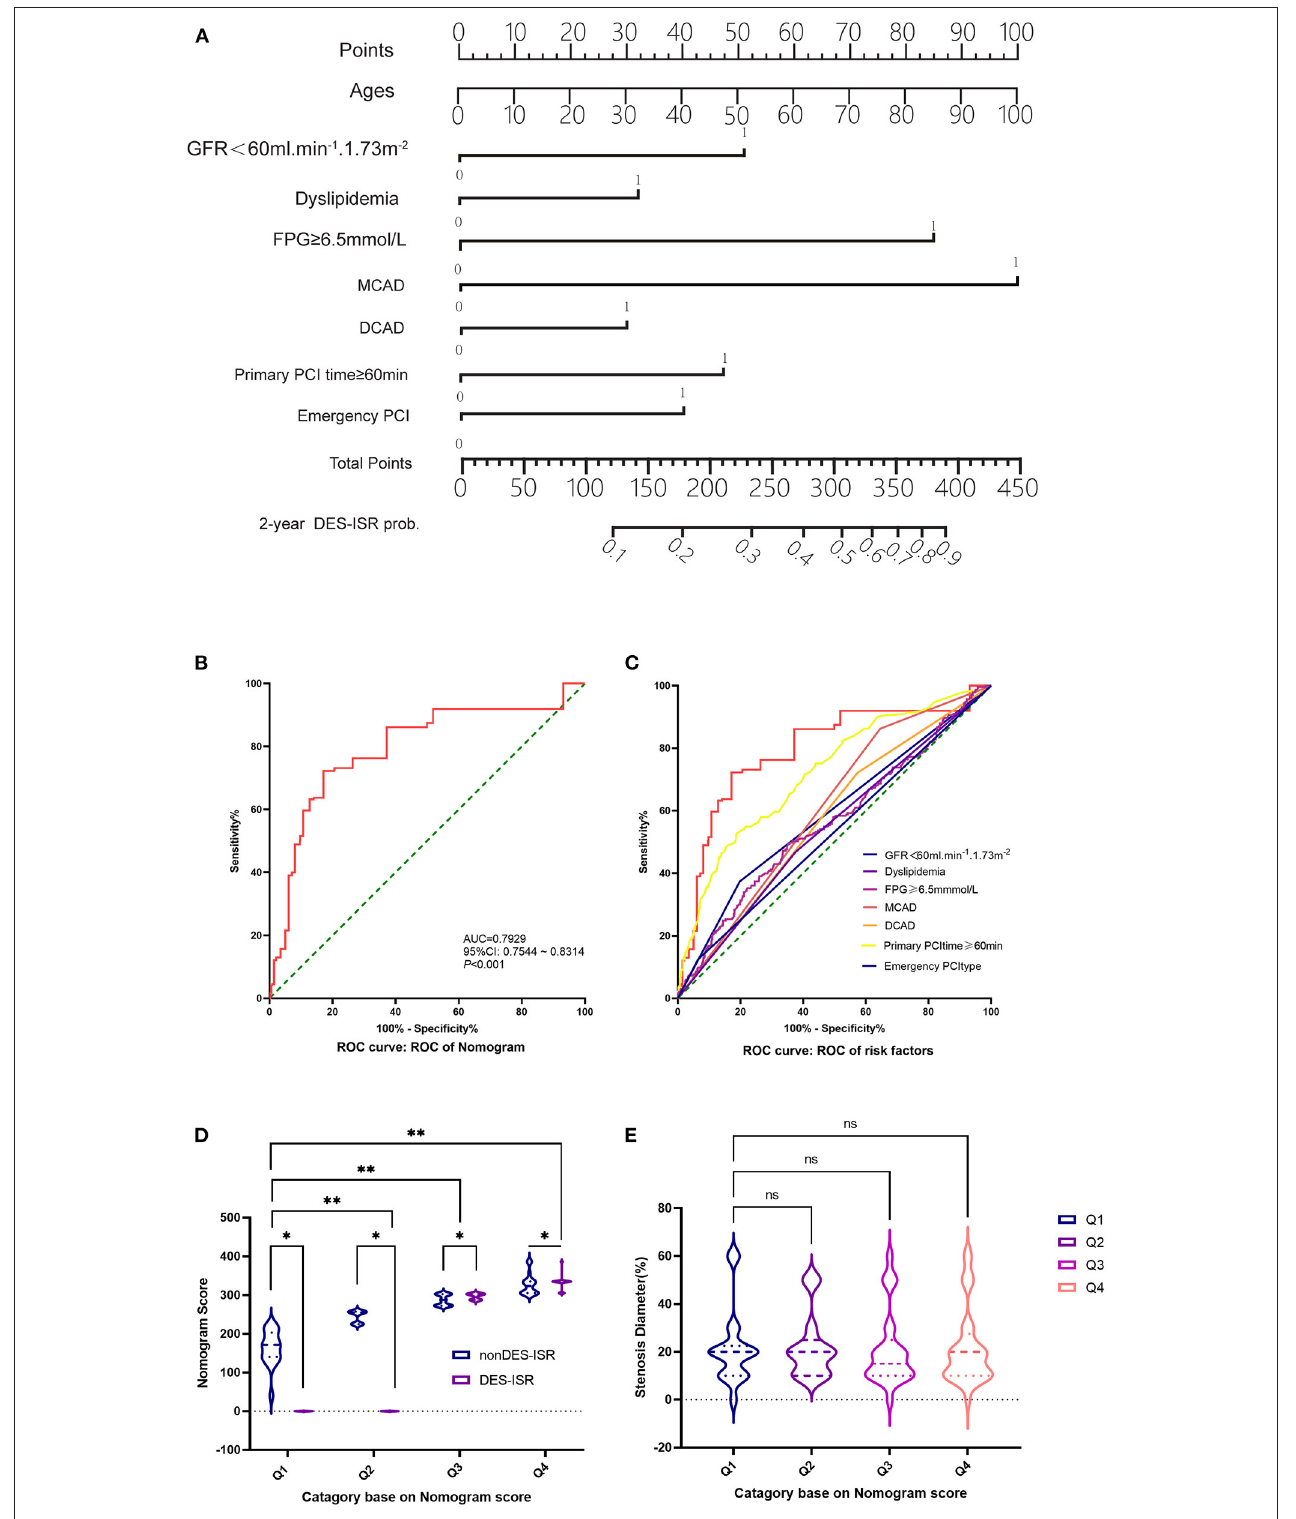
FIGURE 2 | The association between Nomogram scores and DES-ISR. (A) Nomogram from the final multivariable analysis of the binary logistic regression model. (B) ROC curve and its diagnostic performance based on the Nomogram. (C) ROC curve and the diagnostic performance of individual risk factors. (D) The nomogram score analysis in non DES-ISR and DES-ISR patients. (E) The stenosis diameter (%) in patients with different category based on the nomogram score. ns = not significant, * P < 0.05, ** P < 0.01.